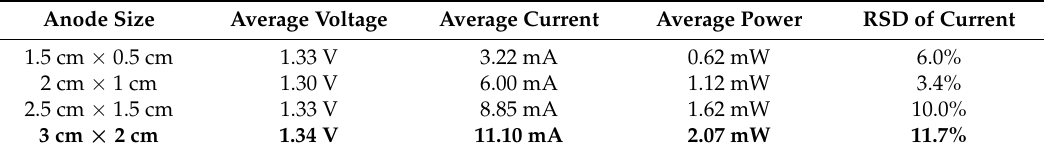
Table 4. Voltage, current, and power of a 9 cm 2 (3 cm × 3 cm) chip with varying aluminum area and 2 cm 2 (2 cm × 1 cm) cathode area with constant 1 M KOH. The optimal area size for aluminum was 6 cm 2 (3 cm × 2 cm).